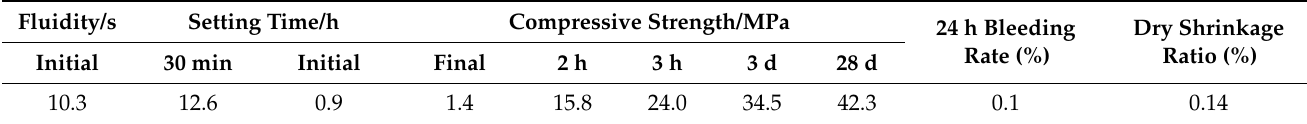
Table 3. Main properties of grouting